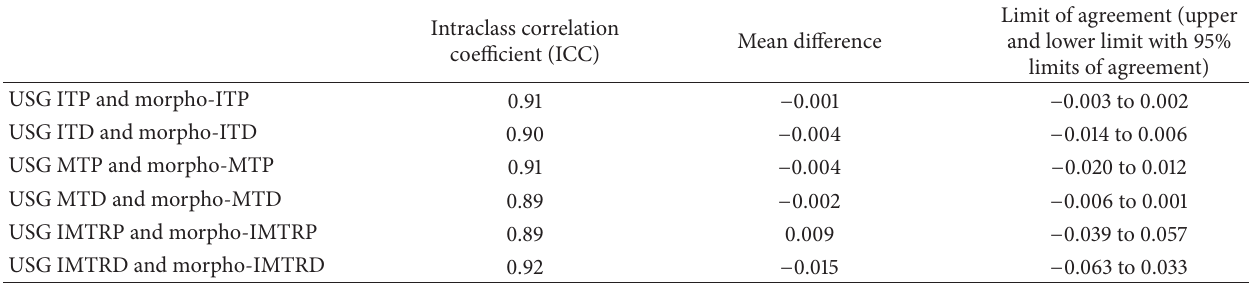
Table 4: Comparison of USG and histology based morphometry; IMTRD: intima-media thickness ratio distal, IMTR: intima-media thickness ratio proximal, ITD: intimal thickness distal, ITP: intimal thickness proximal, MTD: medial thickness distal, and MTP: medial thickness proximal.